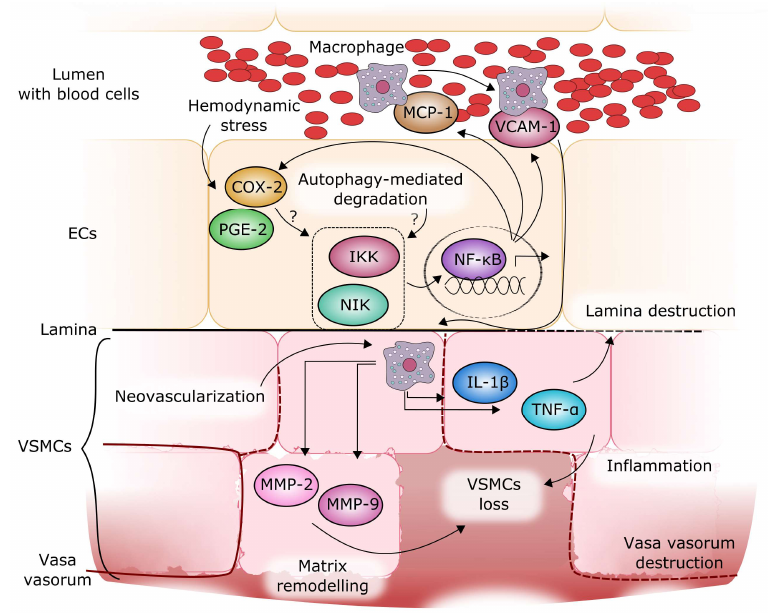
Figure 4. Molecular mechanism of intracranial aneurysm (IA) formation and progression. A wall